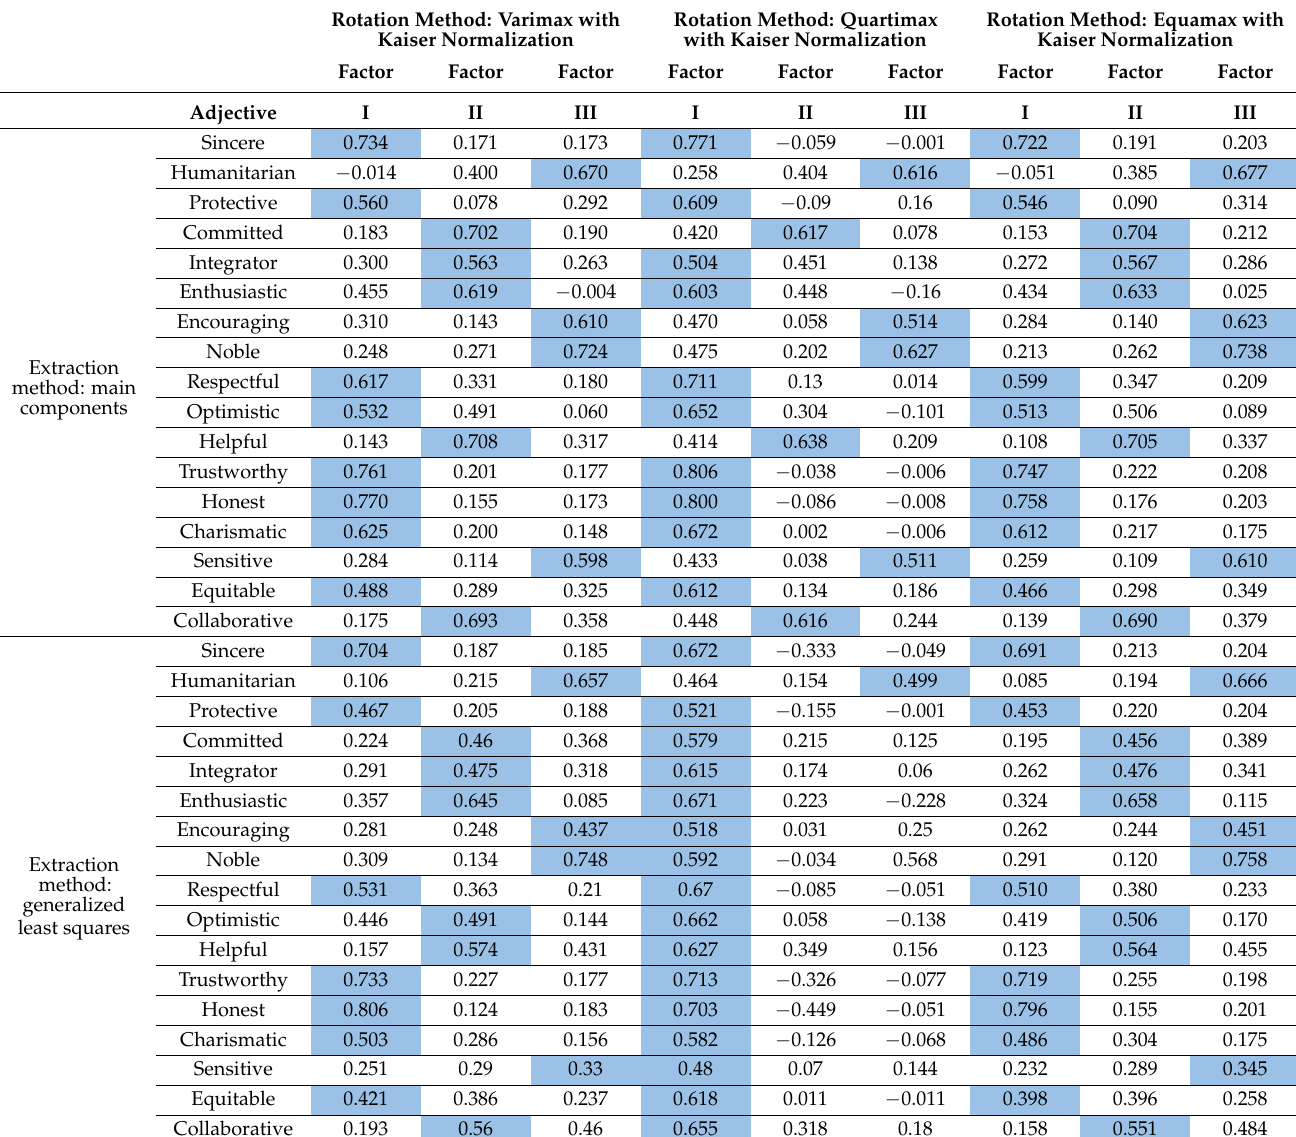
Table 4. Factor loads of factorial scenarios (three factors). Rotation Method: Varimax with Kaiser Normalization